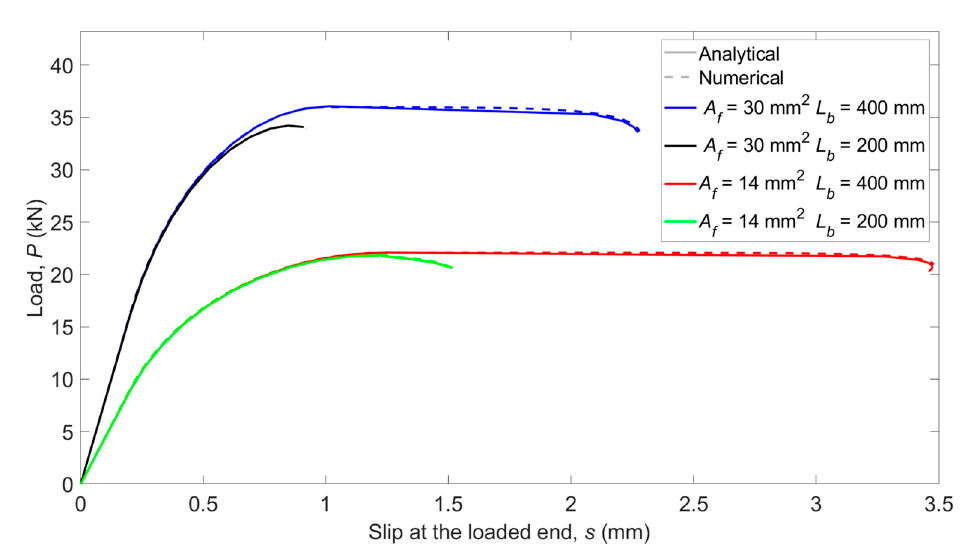
Figure 4. Comparison between the analytical and the numerical models.